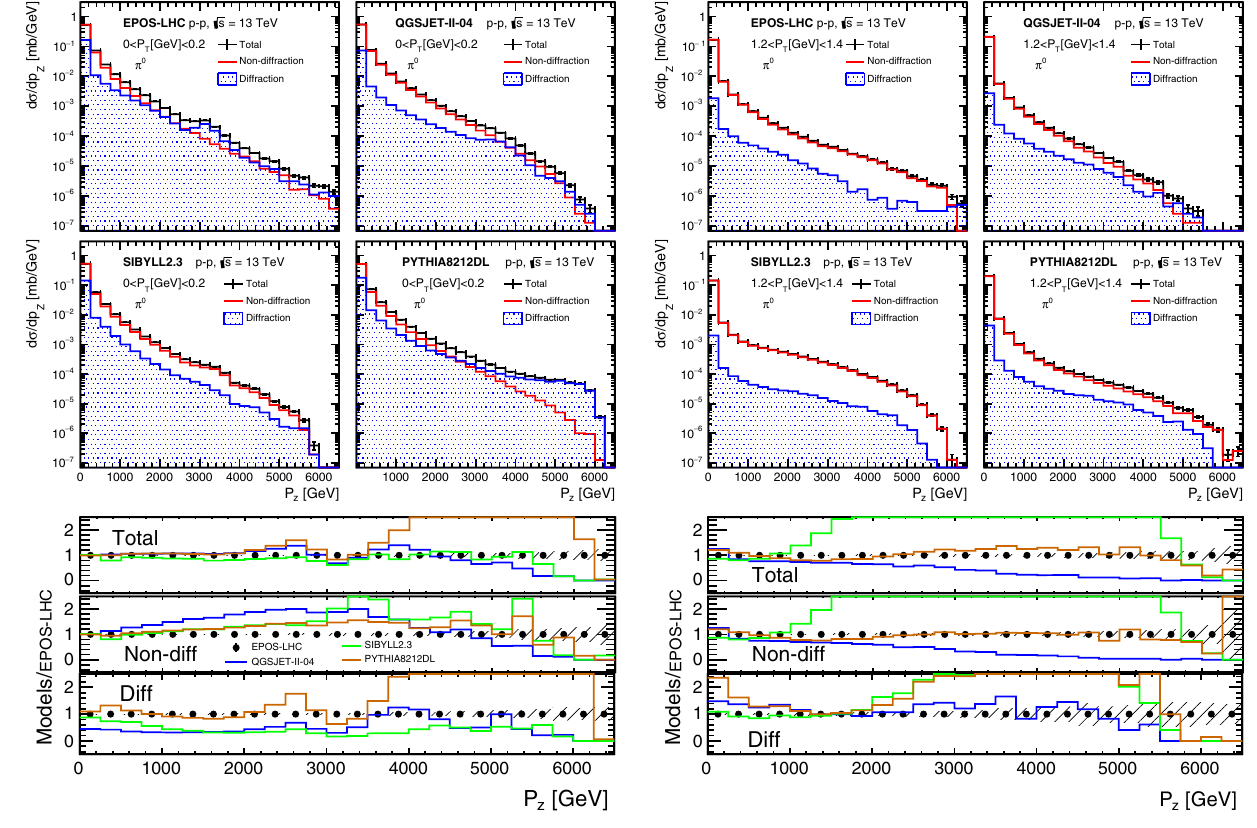
Fig. 5 π 0 spectra shown with 0 < P T < 0 . 2 GeV ( left ) and 1 . 2 < P T < 1 . 4 GeV ( right ) for comparison. In each P T phase region, the top four panels show π 0 spectra generated by EPOS-LHC, QGSJET-II-04, SYBILL 2.3, and PYTHIA 8212DL, respectively. The total π 0 spec- tra ( black ) were classified by nondiffraction ( red ) and diffraction ( blue )